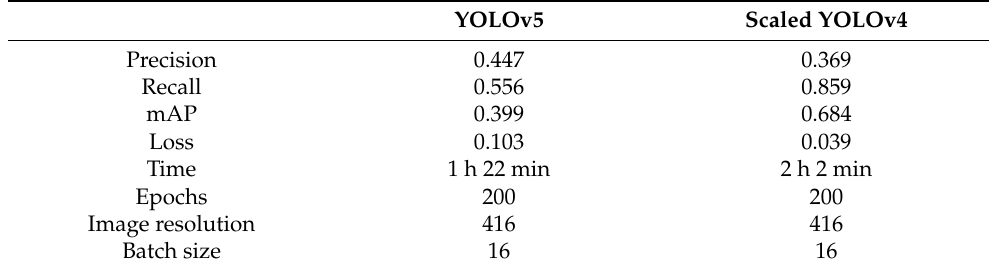
Table 6. Comparison of the results for stage classification with the revised dataset.